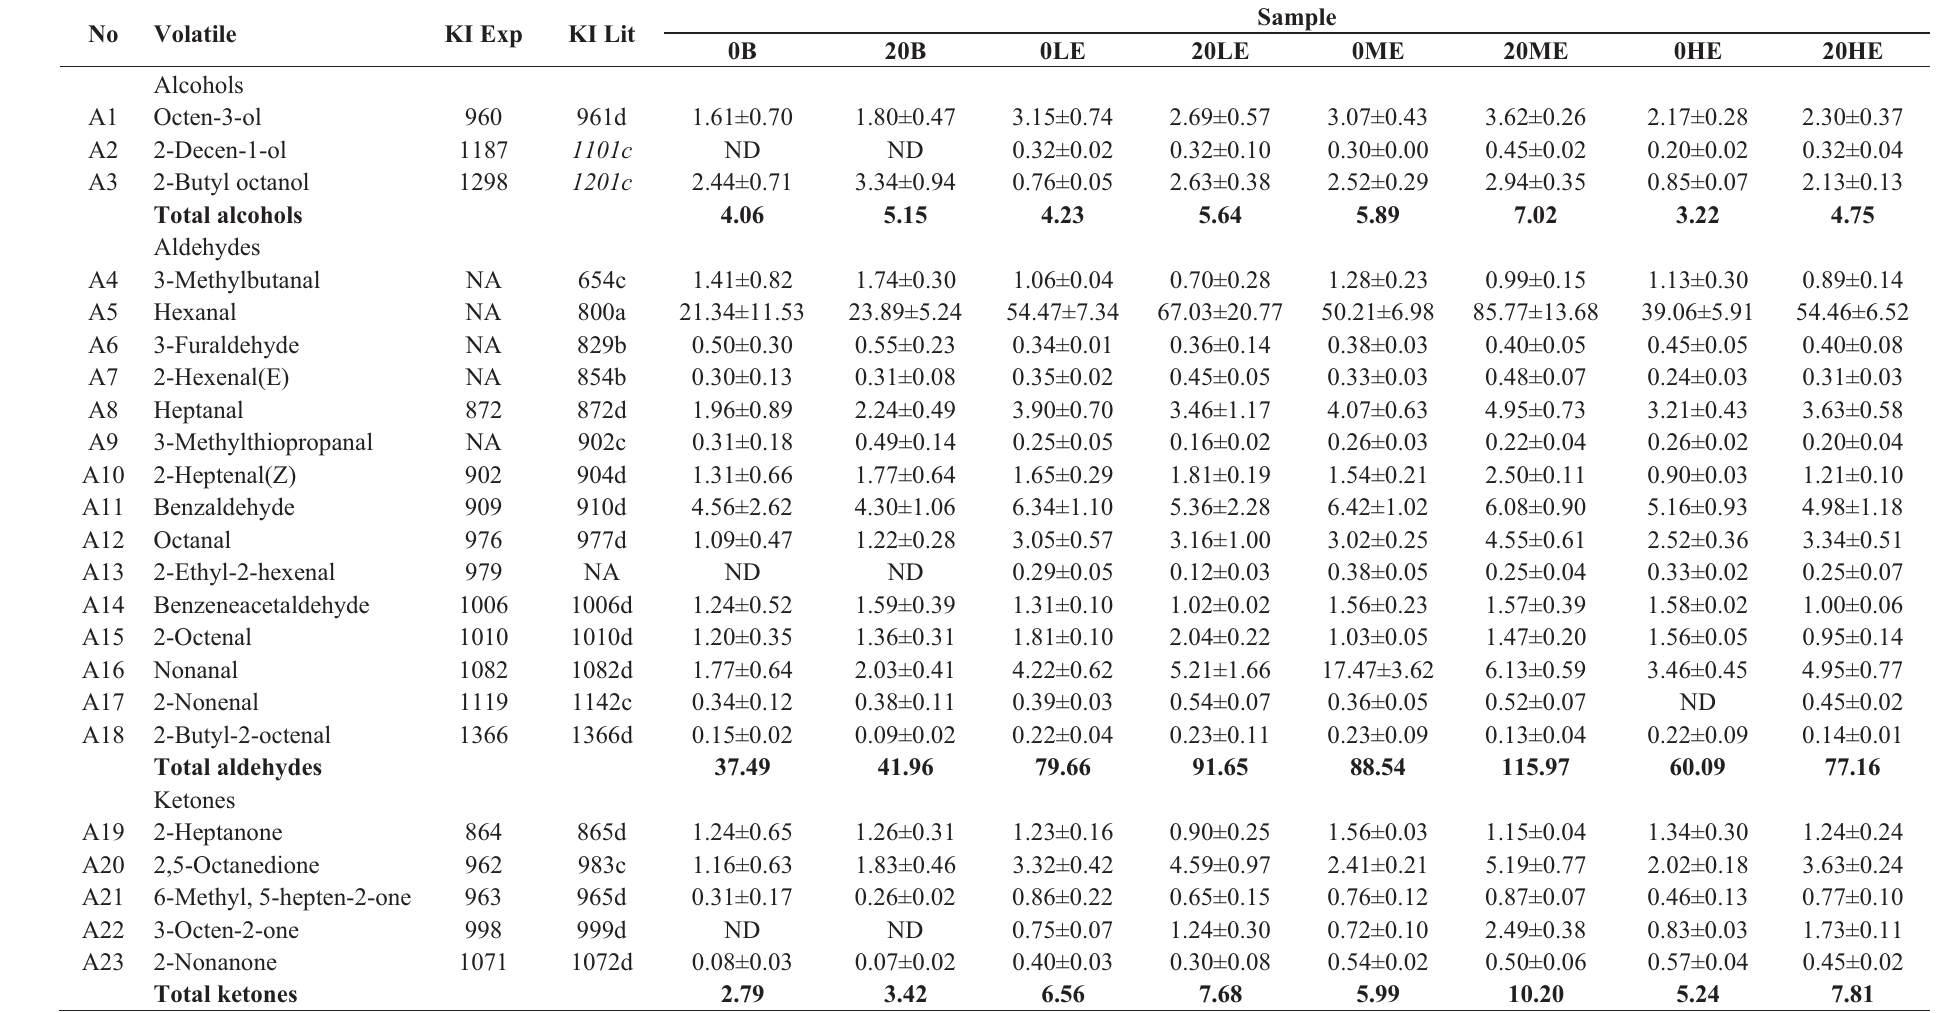
Table 3a. Volatile compounds in samples